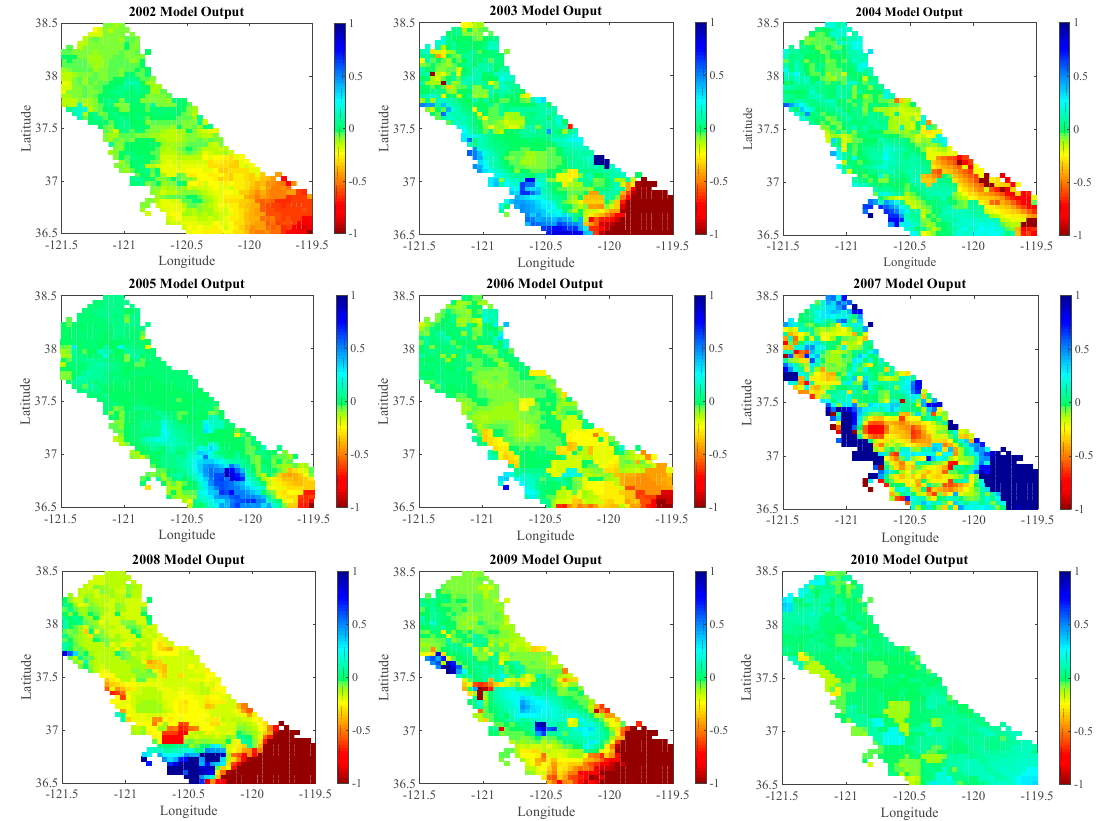
Figure 4. Neural network model downscaled groundwater storage change (m) maps from 2002–2010 of San Joaquin, Central Valley, CA.